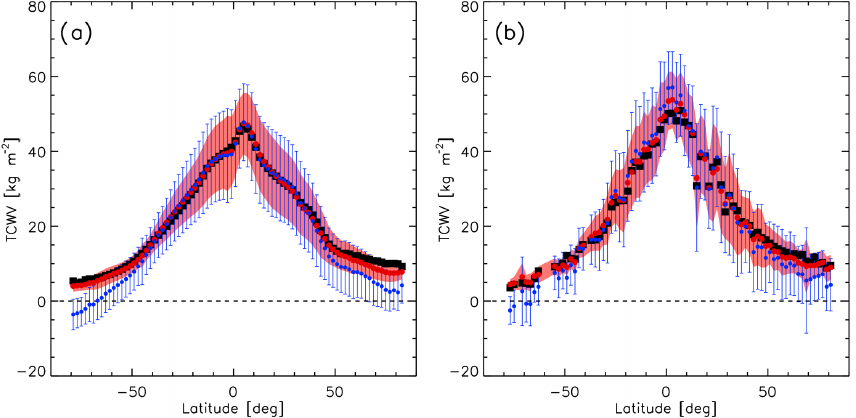
Figure 5. Zonal means of TCWV for AIRWAVEv1 (blue), AIRWAVEv2 (red) and correlative measurements (black): SSM/I (a) or ARSA (b) . The data have been averaged in 2 ◦ latitude bins. AIRWAVE TCWV standard deviations are also